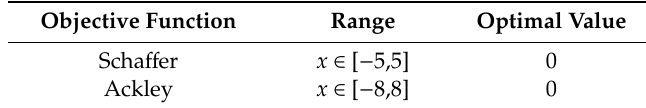
Table 3. Parameter settings.